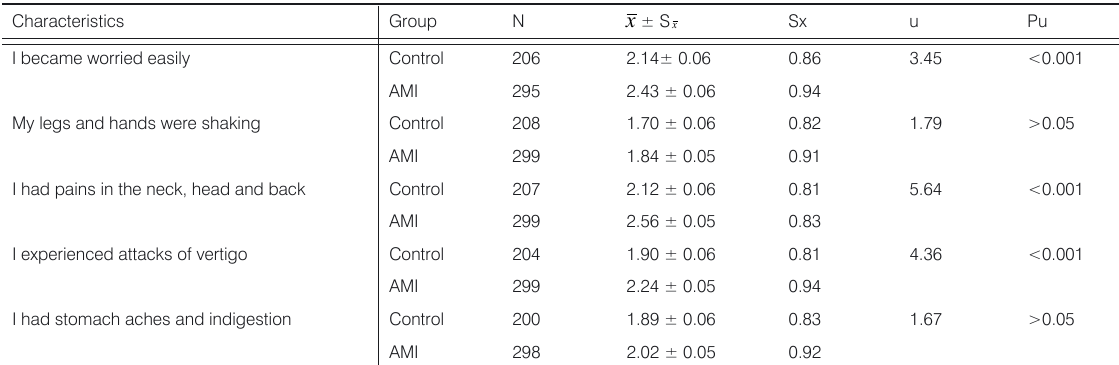
Table 5. Levels of anxiety in